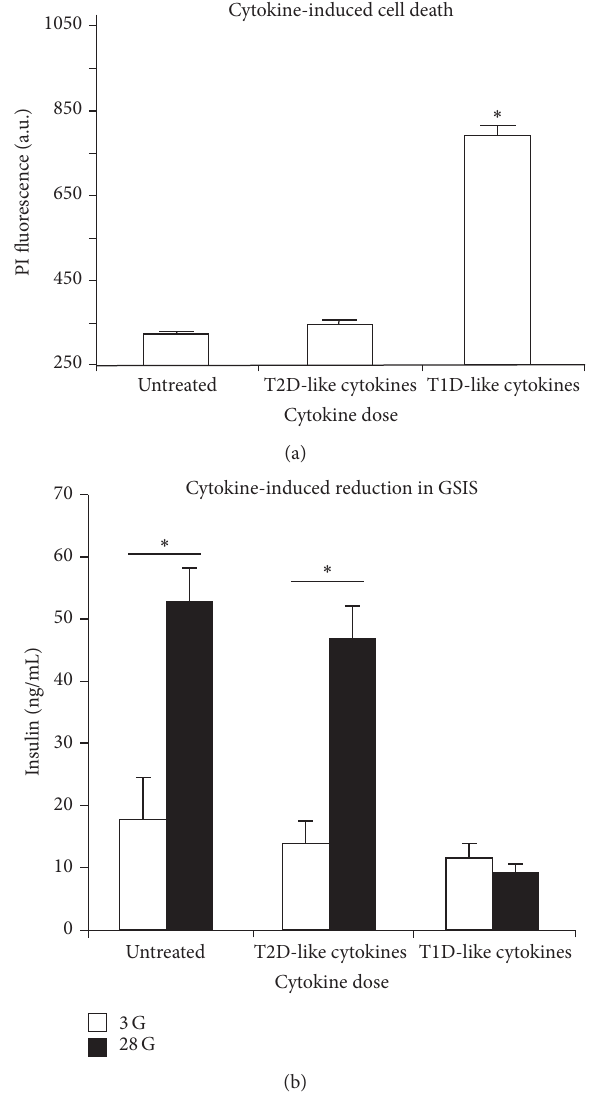
Figure 2: Islet viability and function following overnight treatment with different cytokine concentrations.(a) Cell death measurements by propidium iodide (PI) were made on islets following treatment with Roswell Park Memorial Institute 1640 media (untreated), 10pg/mL IL-1beta + 20 pg/mL TNF-alpha + 200pg/mL IFN- gamma(T2D-like),or 500pg/mL IL-1beta + 1000pg/mL TNF-alpha + 10,000pg/mL IFN-gamma (T1D-like). (b) Glucose-stimulated insulin secretion (GSIS) in 3 mM glucose (3G, open bars) and 28 mM glucose (28G, filled bars) following cytokine treatments listed in (a). ∗ 𝑃 value <